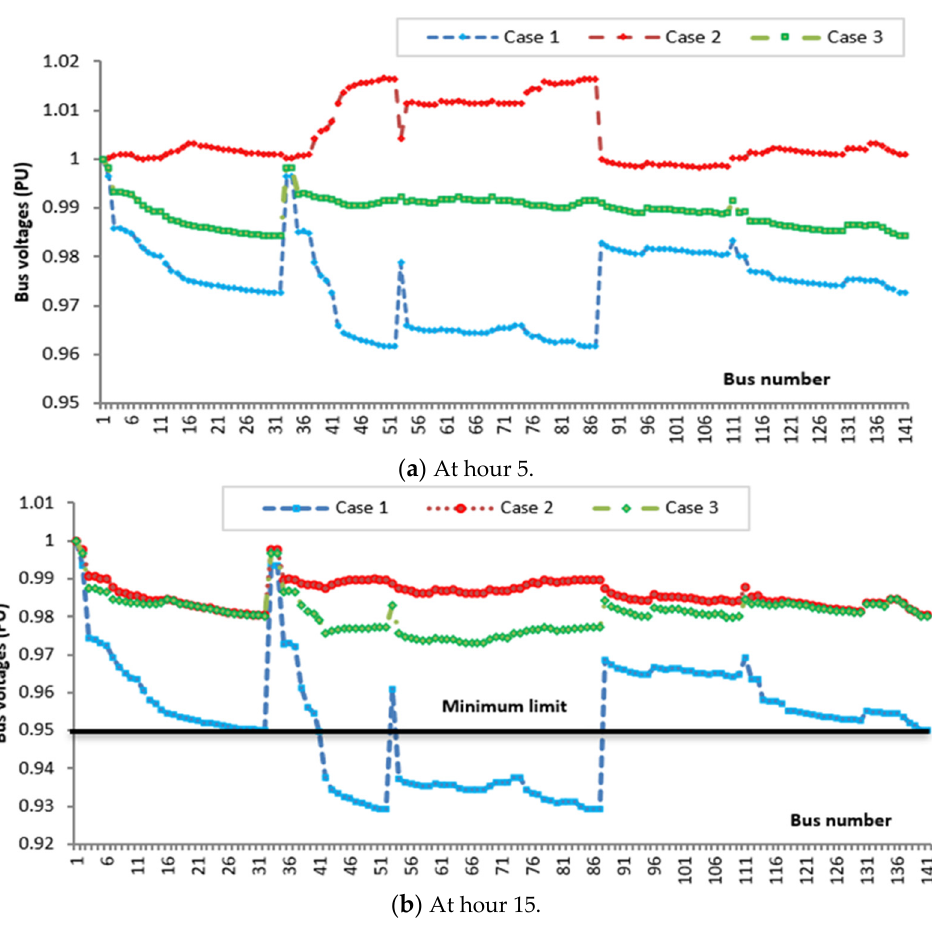
( b ) At hour 15. Figure 22. Bus voltage profiles for different cases studied at hours 5 and 15 for the second MG.